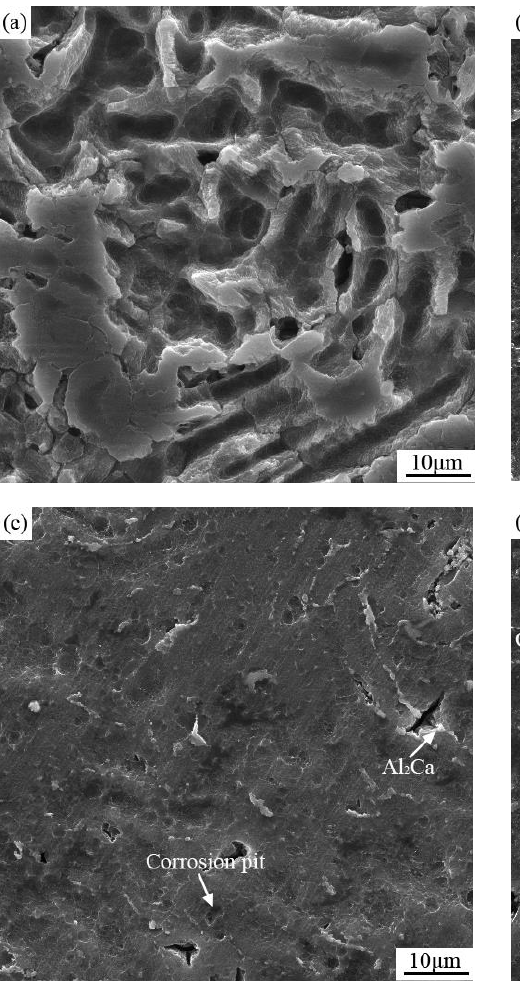
Figure 11. Corroded surfaces of the extruded Mg–7Li–3Al–xCa alloys after immersion for 72 h in a ◦ C: ( a ) x = 0 ( b ) x = 0.4 ( c ) x = 0.8 ( d ) x = 3.5 wt.% NaCl solution at 25 °C: ( a ) x = 0 ( b ) x = 0.4 ( c ) x = 0.8 ( d ) x = 1.2. wt.% NaCl solution at 25